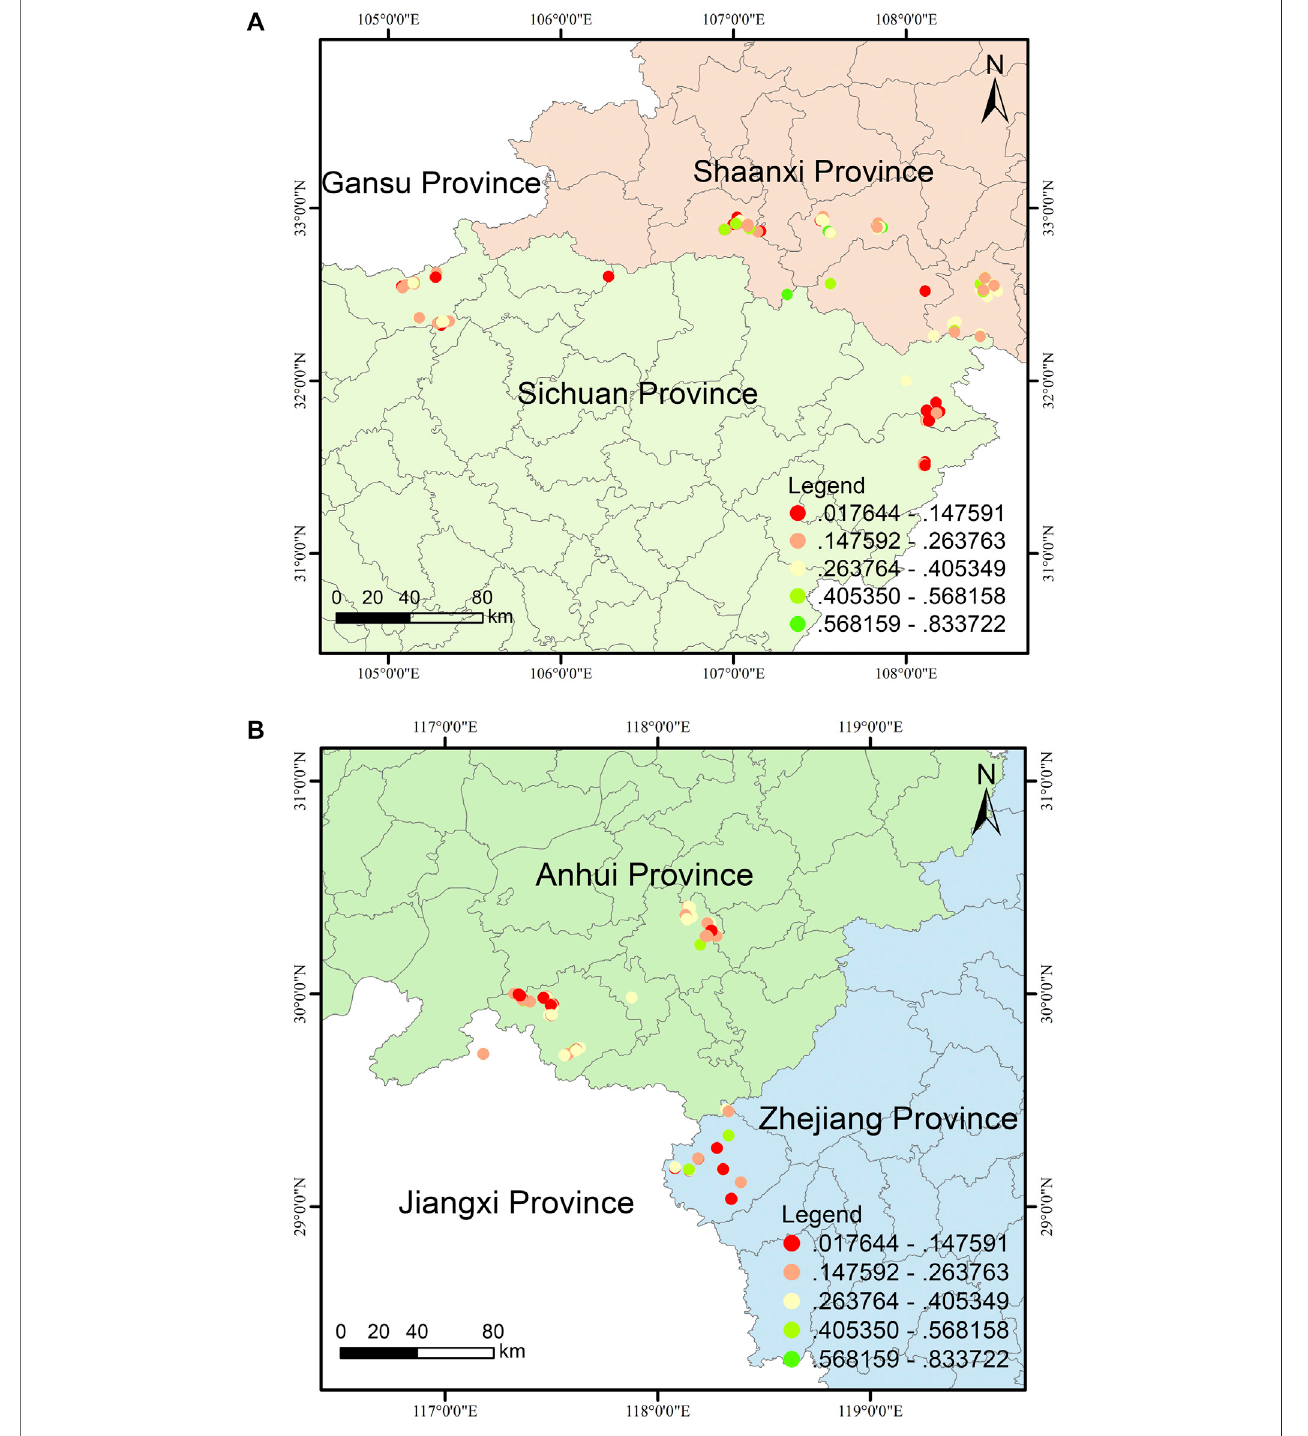
FIGURE 4 | Spatial aggregates of farmers ’ ignorant or unkind non-green production behavior: (A) Qinba Mountain and (B) Huangshan Mountain.